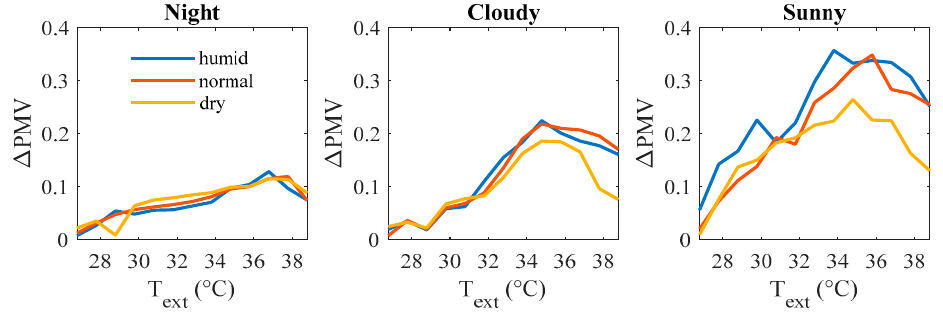
Figure 18. Mean PMV difference between DP and real-time control, for a given HVAC energy.